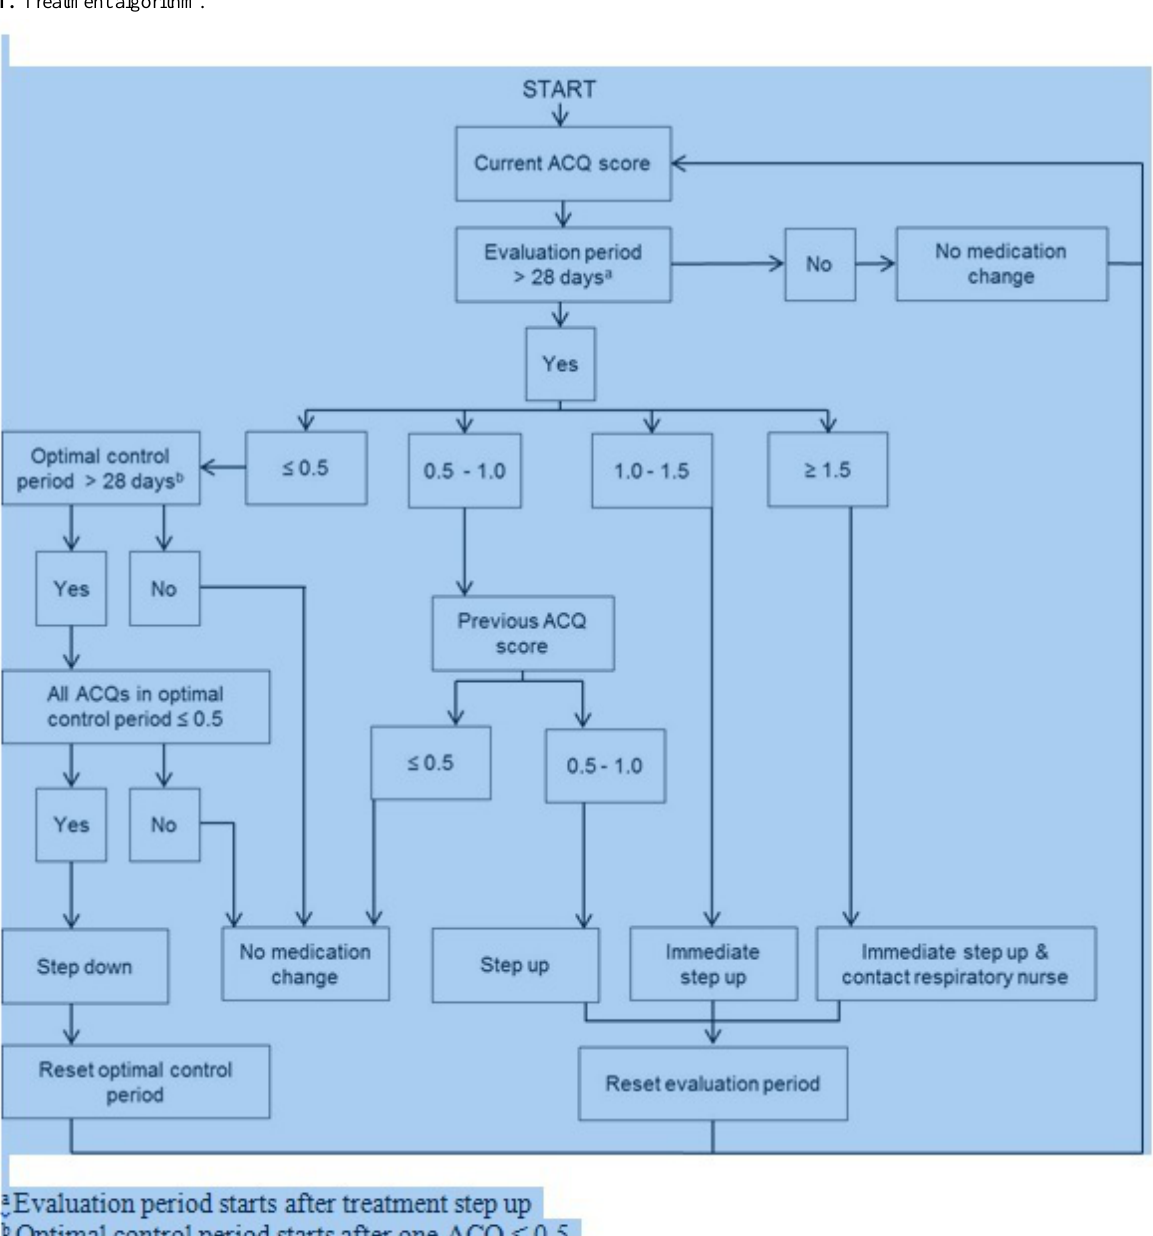
Figure 1. Treatment